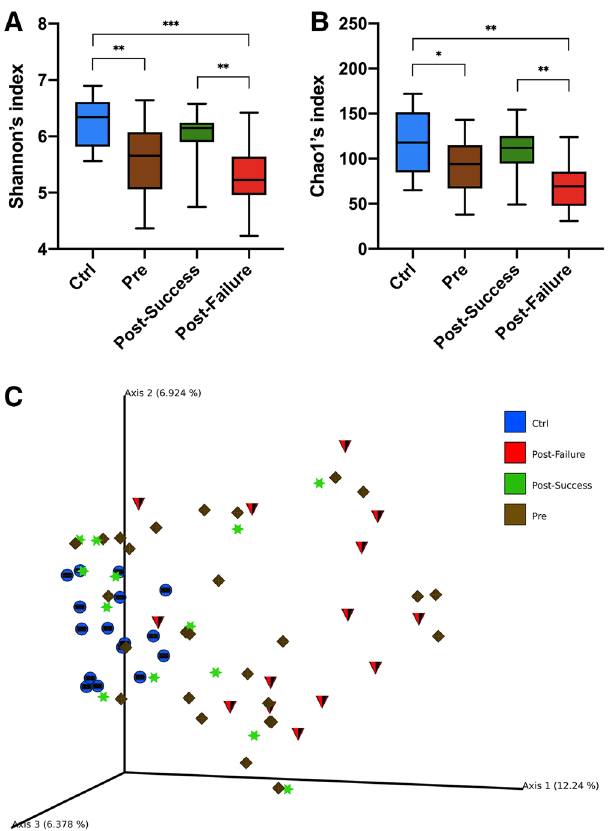
Figure 1. Alpha and beta diversity plots. ( A ) Box-plot corresponding to the Shannon index (alpha diversity). ( B ) Box-plot corresponding to the Chao1 index (alpha diversity). ( C ) Principal coordinates analysis corresponding to the Bray–Curtis dissimilarity index (beta diversity). Statistical analysis using the Kruskal– Wallis test with Benjamini–Hochberg correction for multiple comparisons (false discovery rate). Asterisks refer to the corrected p-value, where *p-value < 0.05, **p-value < 0.01 and ***p-value <